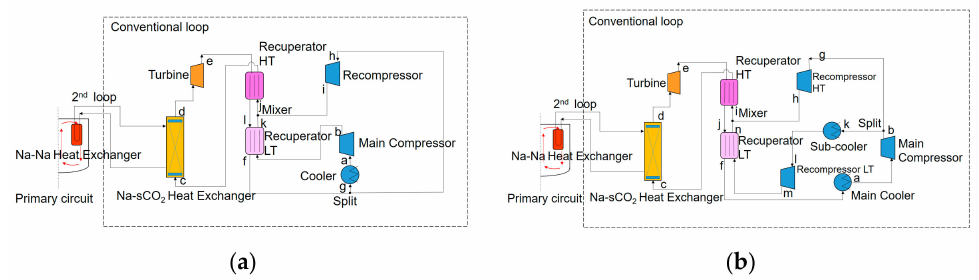
Figure 4. Advanced cycle layouts of sCO 2 -SFR. ( a ) Recompression cycle, ( b ) partial cooling cycle. a–n represent state points of working fluid in the cycle.